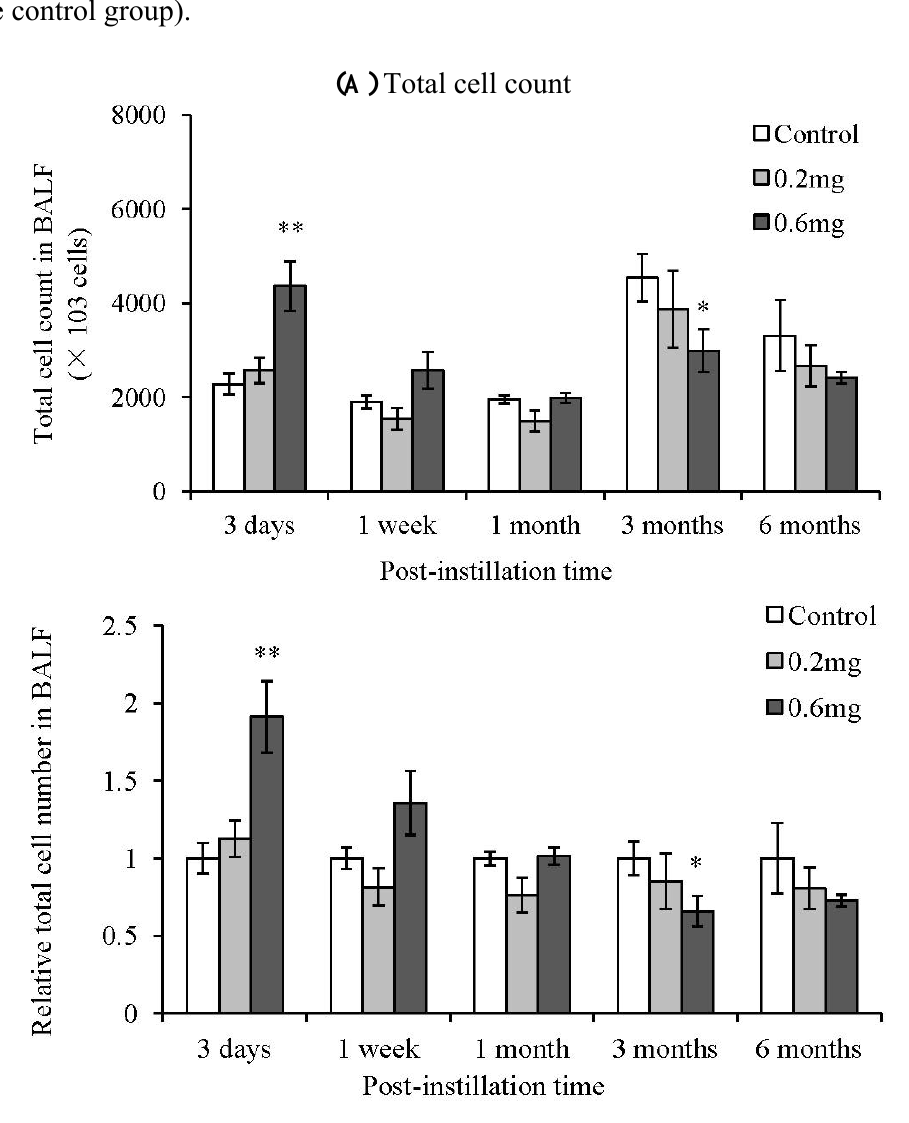
Figure 3. Bronchoalveolar lavage fluid (BALF) results after intratracheal instillation of MWCNT. ( A ) Total cell count; ( B ) Neutrophil cell count. Lower panels show relative level of the cell count in BALF. Values are mean ± SE ( n = 5). * p < 0.05, ** p < 0.01 ( vs. each negative control